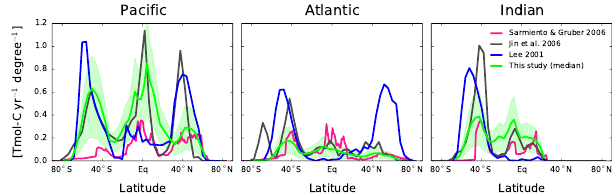
Figure 11. Zonally integrated export fluxes of the constrained Bern3D model ensemble (median and 68% confidence interval) compared to estimates by Sarmiento and Gruber (2006), Jin et al. (2006), and Lee